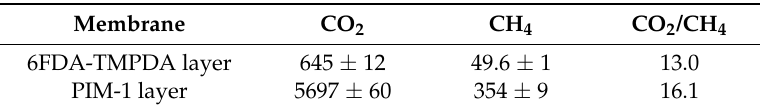
Table 6. Calculated permeabilities (barrer) through composite membranes’ 6FDA-TMPDA and PIM-1